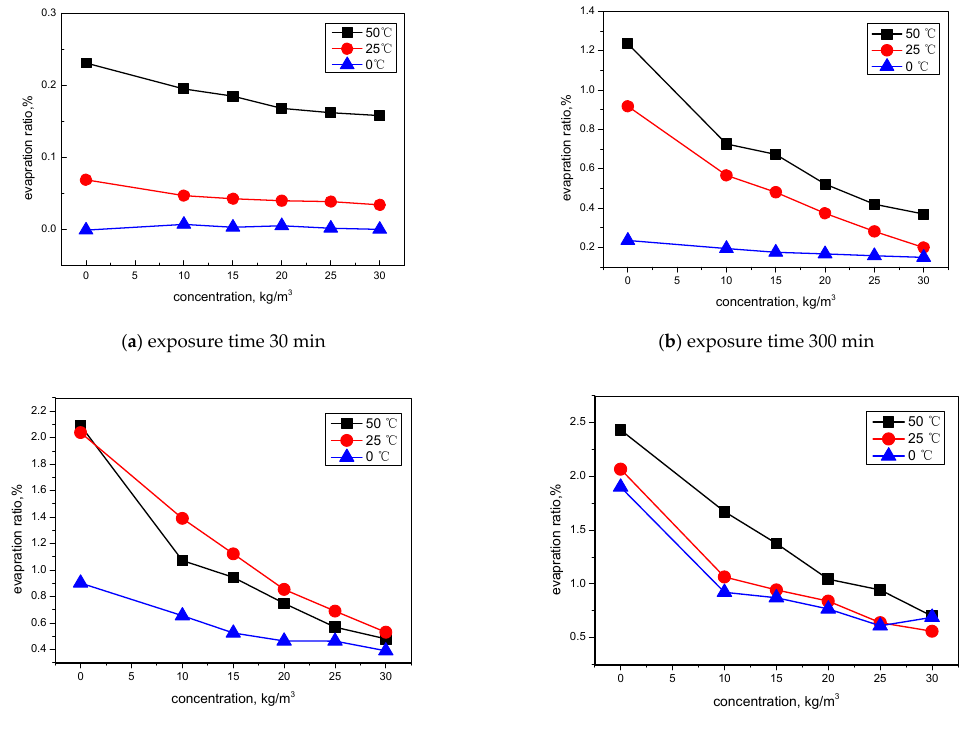
Figure 4. Water evaporation ration with different dosages of TIA and exposure times: ( a ) 30 min, ( b ) 300 min, ( c ) 1440 min, and ( d ) 5760 min. The content of TIA has less effect on the evaporation of concrete during the initial exposure time (Figure 4a), while as the exposure time lasts, especially for long-time exposure, the inhibition effect of the hydrophobic substances on the evaporation rate is more significant, and the inhibition effect of the hydrophobic substances on the evaporation rate gradually decreases with the increase in dosage. The influence of the exposure time on the water evaporation rate is also one of main factors in water evaporation. At the initial exposure time, the total evaporation amount is relatively less; as the time prolongs, the evaporation amount increases sharply for blank specimens. For concrete treated by a hydrophobic admixture, the evaporation ratio increases slowly, and more content of TIA also inhibits the water evaporation even more. After a longer time of exposure, the gap between the total amount of water evaporation becomes prominent, and the influence of the hydrophobic substance content on the water evaporation rate gradually increases. 3.2. Chloride Ion Diffusion Figure 5 shows the depth distribution curve of chloride ion migration and penetration in concrete after the dry–wet cycle. The results show that the distribution of chloride ions increases with depth within 5 mm of the surface of the specimen; then the total number of chloride ions reaches a certain peak value, after which the concentration gradually decreases. When TIA was added to the concrete, the distribution law of total chloride ions in concrete with depth was consistent with that in the benchmark specimen,